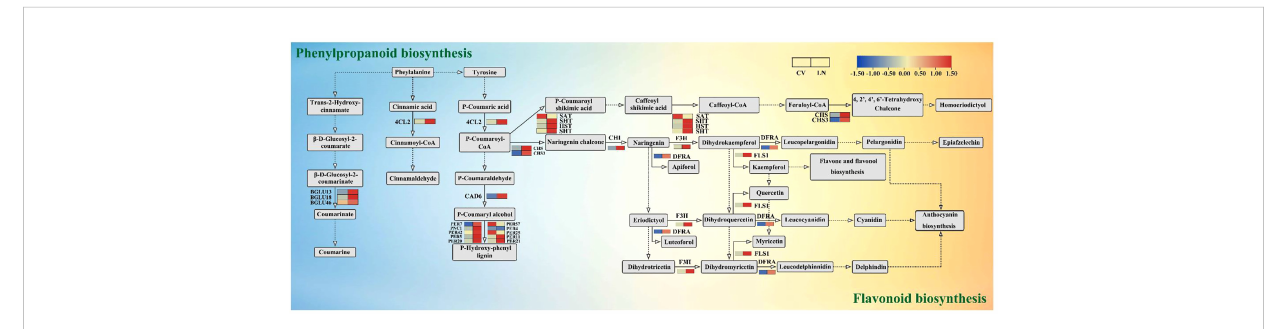
FIGURE 9 DEGs in the metabolic pathways of phenylpropanoid metabolism and fl avonoid biosynthesis under LN. DEGs, differentially expressed